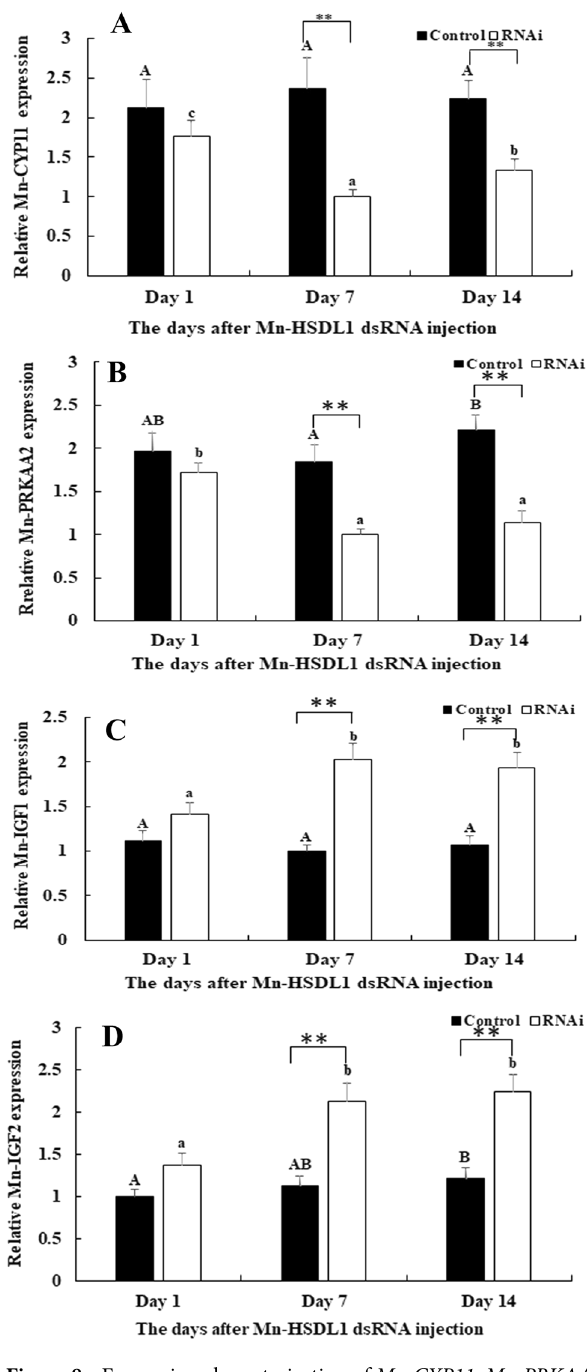
Figure 8. Expression characterization of Mn-CYP11 , Mn-PRKAA2 , Mn-IGF1 and Mn-IGF2 at different days after Mn-HSDL1 dsRNA injection. The amount of mRNA expression was normalized to the EIF transcript level. Data are shown as mean ± SD (standard deviation) of tissues from three separate individuals . Capital letters indicate statistically significant expression differences between different days after GFP dsRNA injection in control group. Lowercase indicated expression difference between different days after Mn-HSDL1 dsRNA injection in the RNAi group. ** ( P < 0.01) indicates a significant expression difference between the RNAi group and control group at the sample day. ( A ) Expression characterization of Mn-CYP11 . ( B ) Expression characterization of Mn-PRKAA2 . ( C ) Expression characterization of Mn-IGF1 . ( D ) Expression characterization of Mn-IGF2